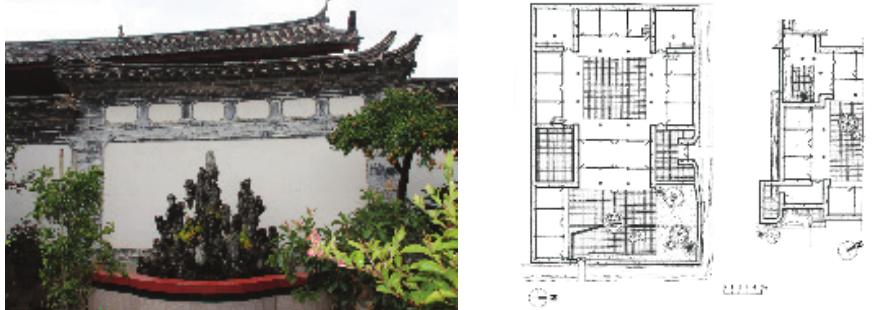
Figur e 11. Water feature in courtyard (left ) (photo by the fi rst author); fl oor plan of cases that channelled water from external creeks into courtyards (right) (source: Zhu, 2020; personal communication, 18 January)